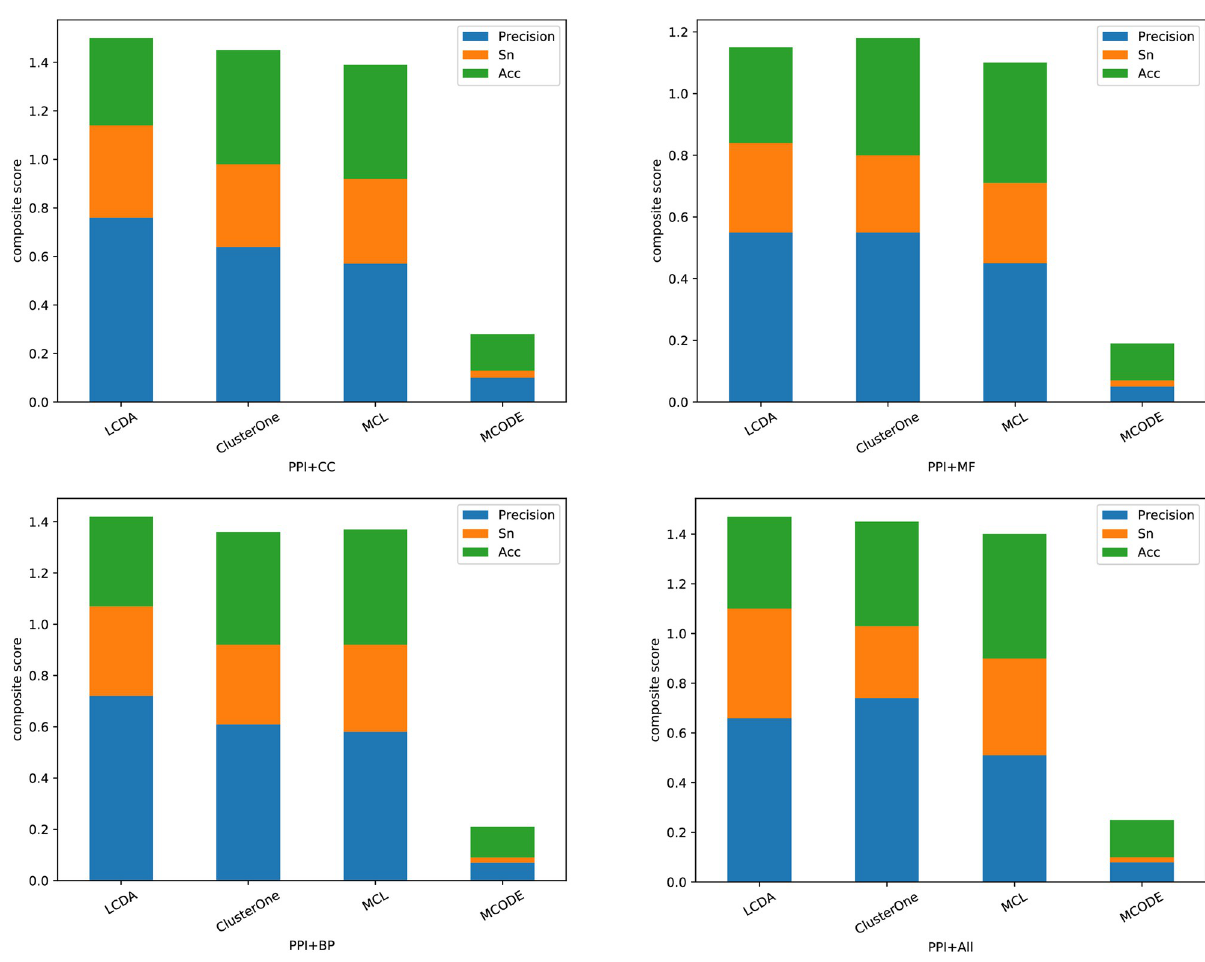
Fig 2. Composite score including Precision , Sn , and Acc .